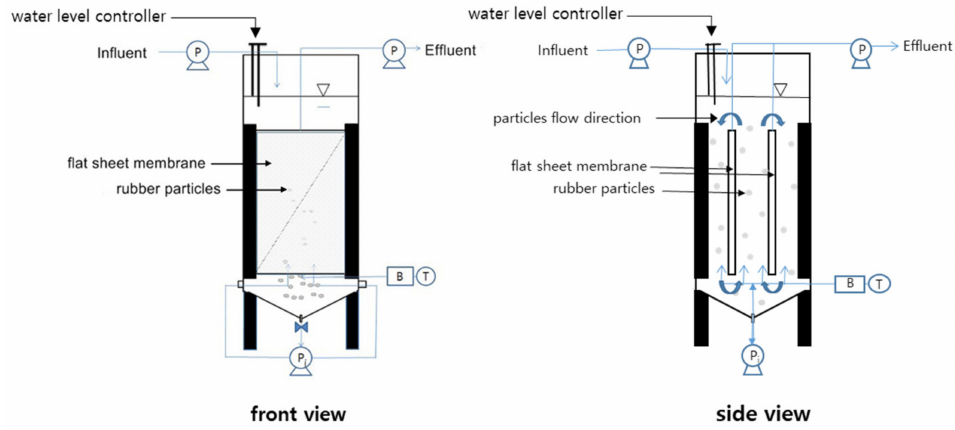
Figure 1. Configuration of MBR system. P: pump, P i : pump for internal circulation, B: blower for air supply, T: